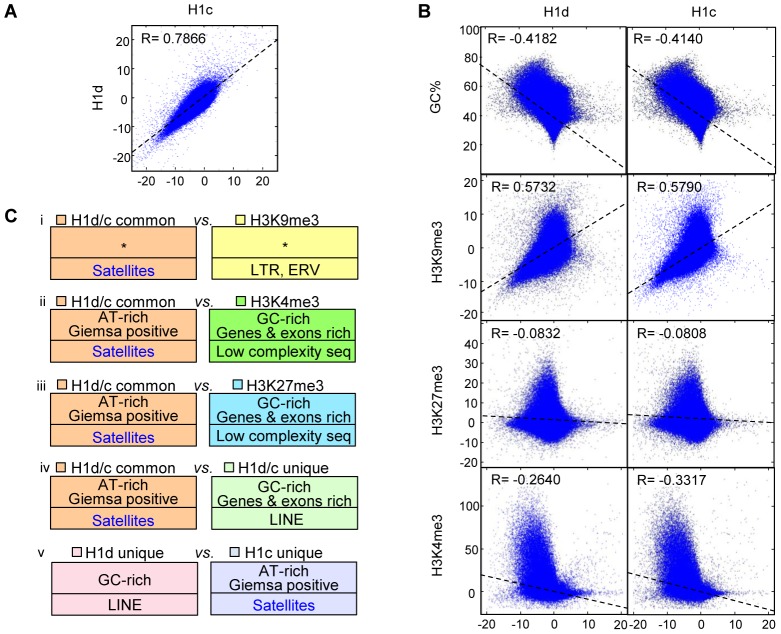
Correlation and over-representation analyses of H1 variants and histone marks.(A–B) Genome-wide correlation scatter plots of H1d vs. H1c (A), and GC% (or histone marks) vs. H1d (left) and H1c (right) (B). The correlation coefficient and the trend line were generated as described in methods. X and Y axes: average signal values (normalized to 100 bp window). Pearson's correlation was used to perform the analysis. P<10−100 for all correlation coefficient. (C) Overrepresented features from the following 5 comparisons of H1 or histone mark highly enriched regions; i) H1d/H1c common vs. H3K9me3 regions; ii) H1d/H1c common vs. H3K4me3 regions; iii) H1d/H1c common vs. H3K27me3 regions; iv) H1d/H1c common vs. H1d/H1c unique regions; v) H1d unique vs. H1c unique regions. Bottom half of each box: repetitive elements. *: no significant overrepresentation. All P values remained significant after multiple testing corrections with the FDR method and the more conservative Bonferroni method.